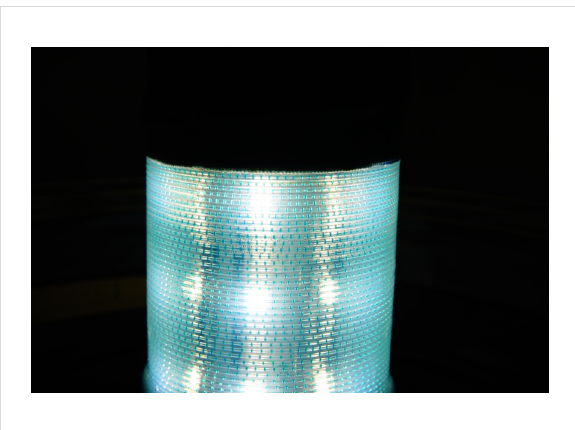
tion but also other spatial distributions (plug flow, bubbly flow, annular flow or isolated gas and liquid segments) can occur under certain conditions (Scheme 3, Figure 6) [67].